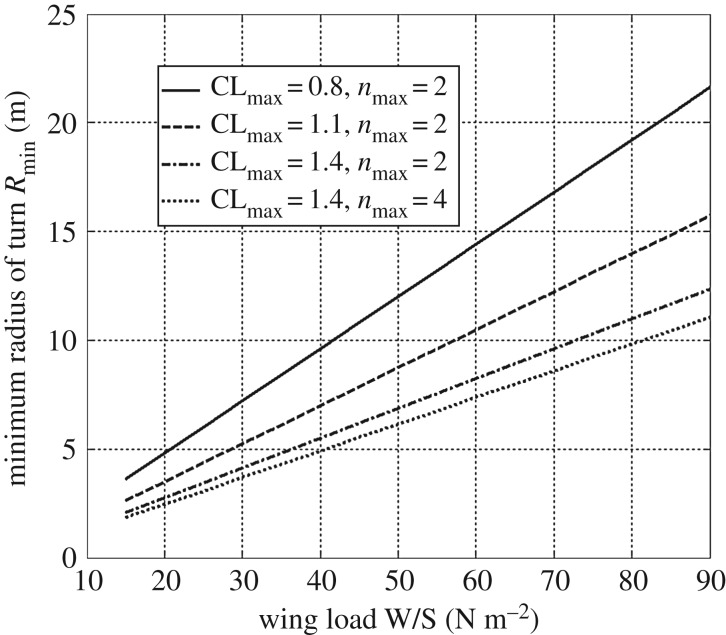
Minimum radius of turn Rmin as a function of nmax, CLmax and W/S.